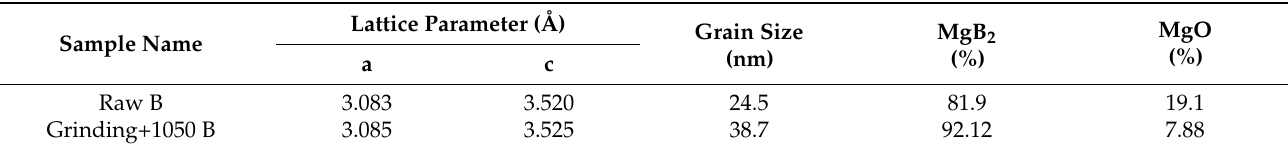
Table 2. Phase formation, lattice parameters, and grain sizes of the MgB 2 bulk prepared using B powder with different purification methods.